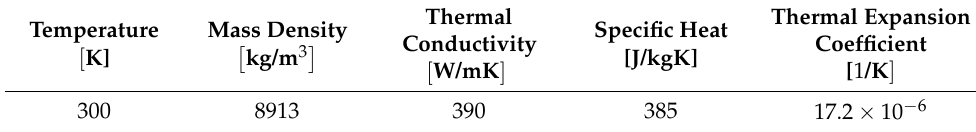
Table 4. Physical properties of electrodeposited OFHC.